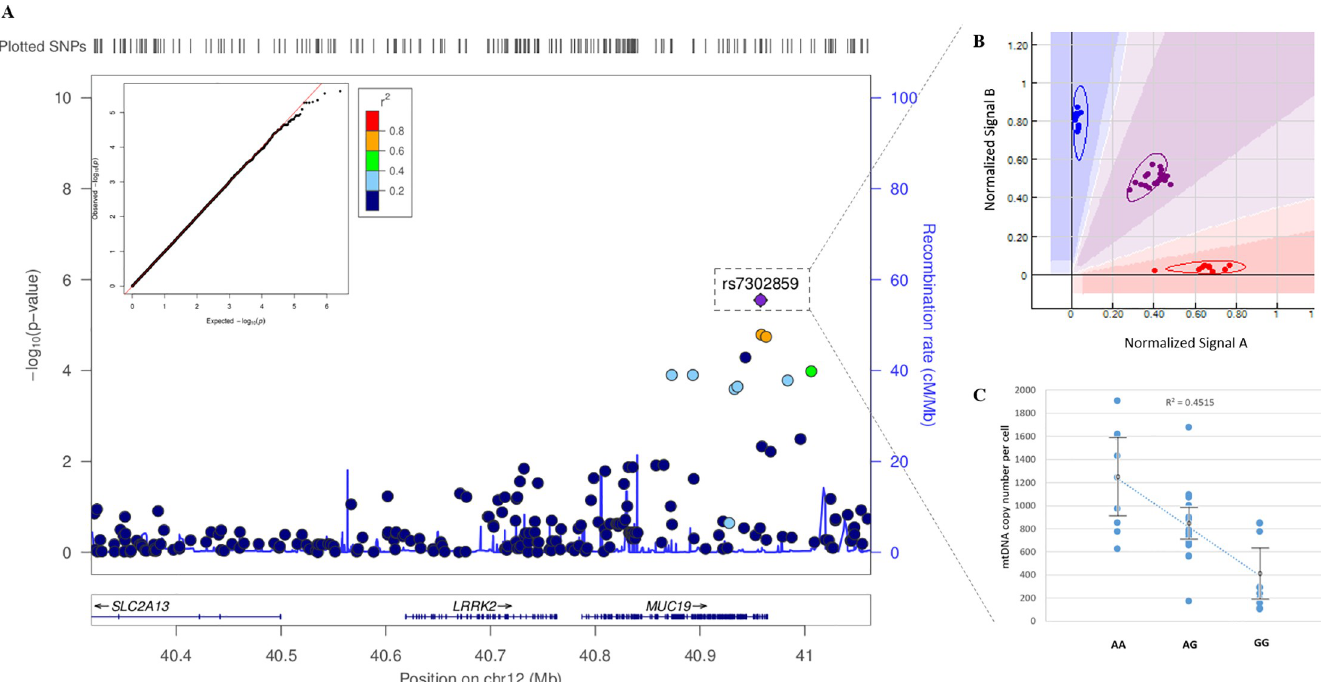
Fig 9. Local plot of association results. (A) Regional SNP-based association results for LRRK2 (LocusZoom). The nest Q-Q plot for single SNP associations (qqman R package) conforms to expectation and does not exhibit signs of genomic inflation. The SNP with the lowest p-value associated with mitochondrial copy number is rs7302859, and the cut-away panel (B) illustrates appropriately called genotype clusters (Genome Studio 2.0, Illumina). Eight additional SNPs in LD (as indicated by points colored according to the r2 key) with the primary SNP also seen within the signal. (C) mtDNA copy number was found to significantly differ between genotype groups after covariate analysis of age, EV1 and EV2 ( p = 0.008 for genotypic difference, followed by p = 0.003 for age; EV1 and EV2 were non-significant).